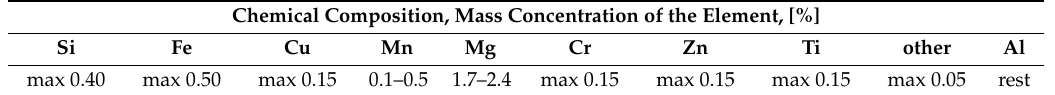
Table 1. Chemical composition of EN-AW-5251 alloy.